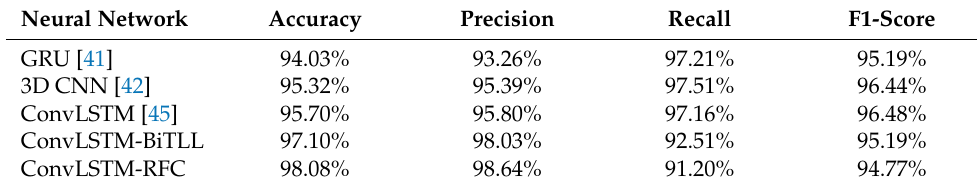
Table 4. Performance metrics results for all the